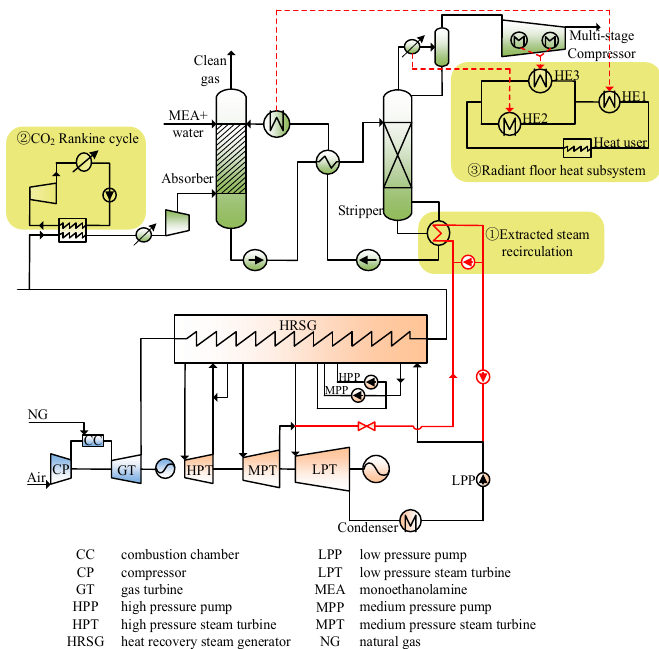
Figure 3. Schematic of a new configuration of NGCC power plant with CO 2 capture.